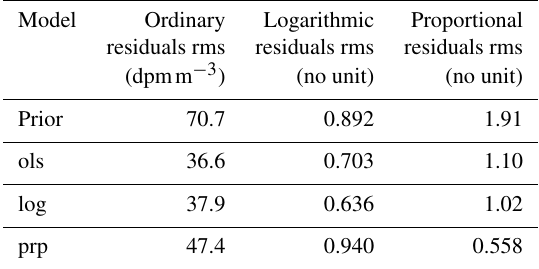
Table 3. Root mean square of residuals before and after inversion Model Ordinary Logarithmic Proportional residuals rms residuals